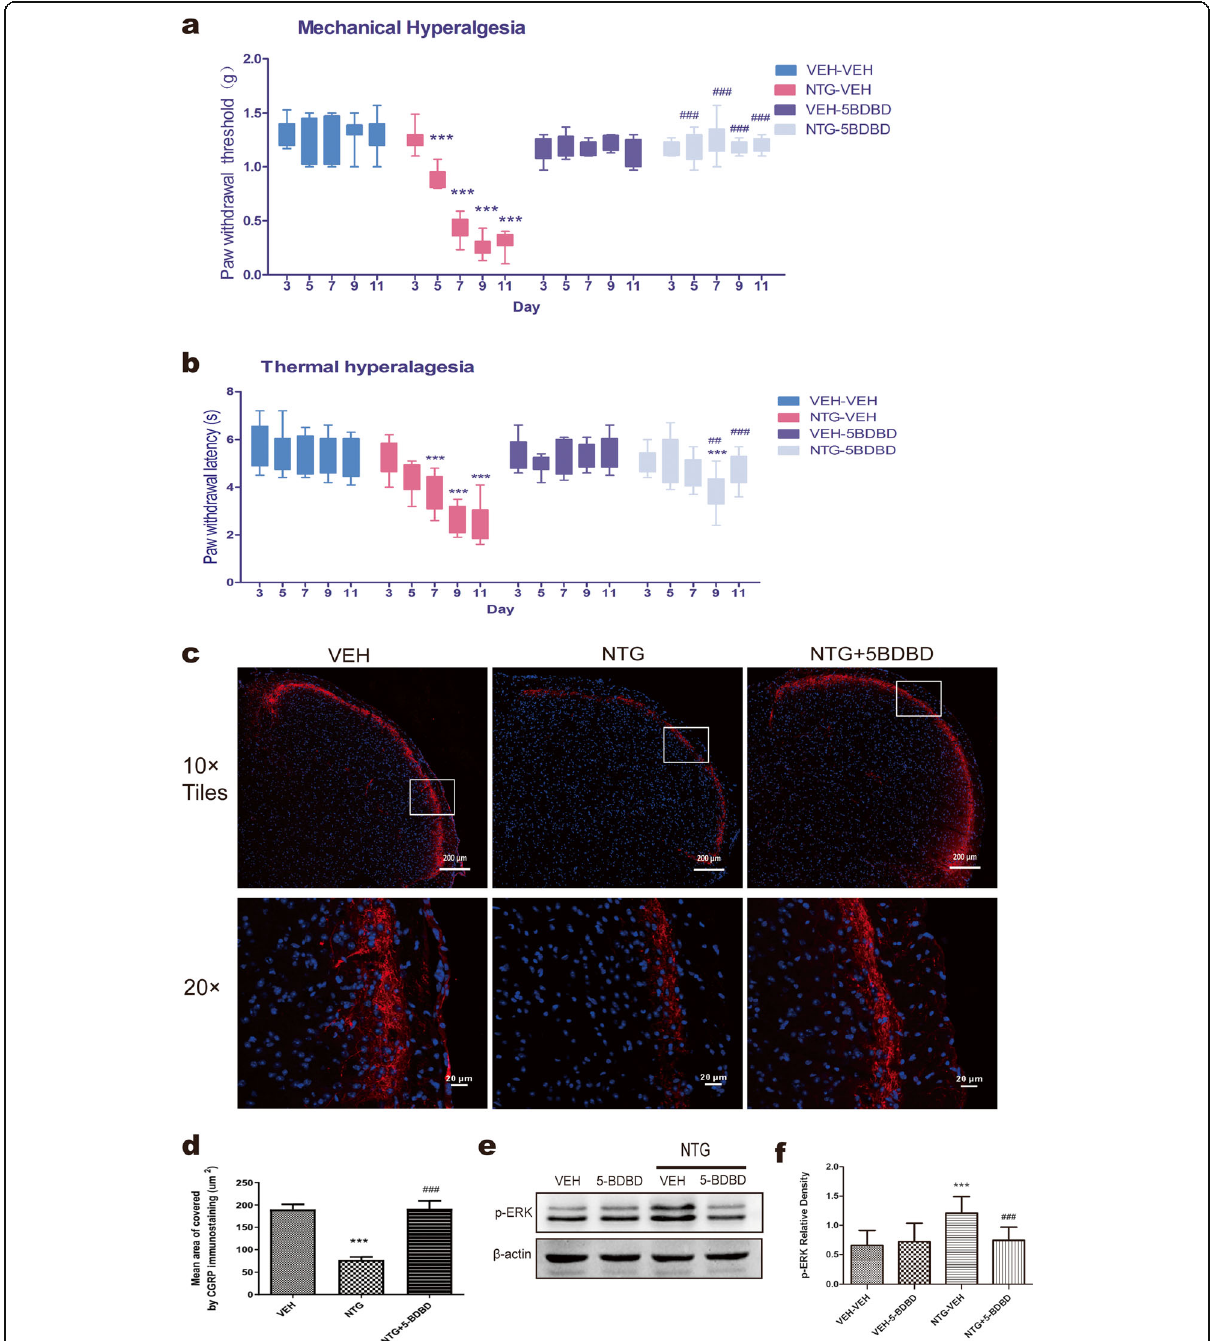
Fig. 3 Effect of 5-BDBD on NTG-induced migraine-related behavioural and neurochemical changes. NTG (10 mg/kg, i.p.) or saline was injected every other day from day 3 to day 11. Mice were treated daily with vehicle (VEH) or 5-BDBD (28 mg/kg, i.p.) for 11 days. a , b Mechanical and thermal sensitivity were assessed in different groups. p < 0.01 for drug, time, and interaction. Two-way RM ANOVA and Bonferroni post hoc analysis. n = 10/group. *** p < 0.001 versus VEH-VEH group. ## p < 0.01, ### p < 0.001 versus NTG-VEH group. c Representative photos of CGRP- immunoreactive staining in the TNC of the VEH, NTG and NTG + 5-BDBD groups under a 10 × objective lens (the upper row, scale bar = 200 μ m) or 20 × objective lens (the lower row, scale bar = 20 μ m). The white box was enlarged. d Mean area covered by CGRP-immunoreactive fibres in different groups. One-way ANOVA and Tukey ’ s multiple comparison test. n = 8/group, *** p < 0.001 versus VEH, ### p < 0.001 versus NTG. e , f Representative Western blot results for p-ERK in different groups. One-way ANOVA and Tukey ’ s multiple comparison test. n = 8/group, *** p < 0.001 versus VEH-VEH, ### p < 0.001 versus